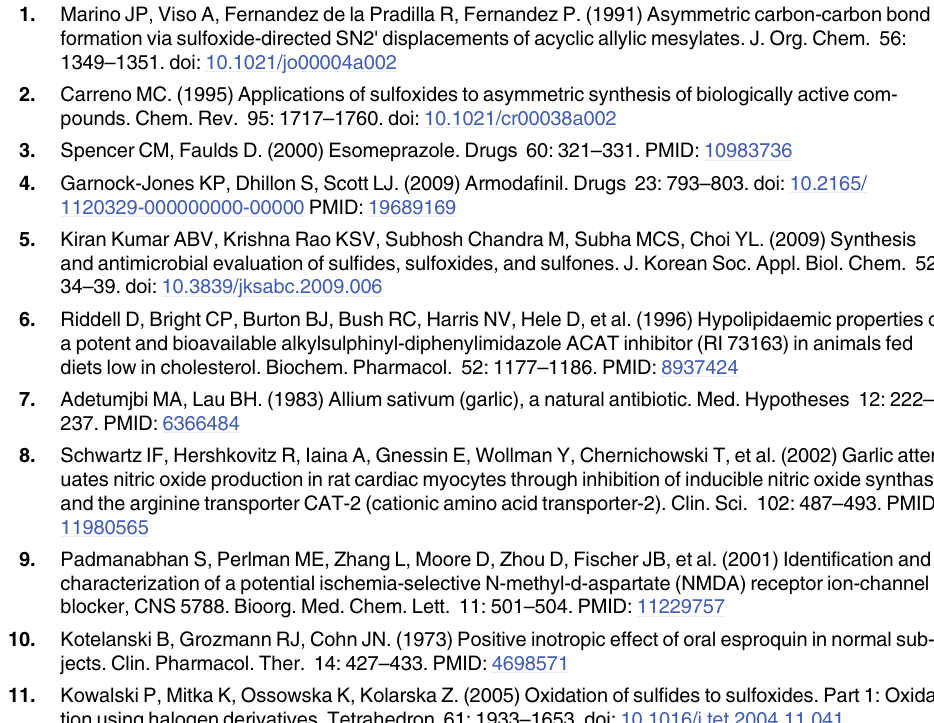
S2 Table. Percentage conversion to sulfoxides and sulfones after 1 and 30 minutes of reac- tion in the presence of D or L-DNAzyme. Reactions were carried out in the presence of DNA O (4 mM). Controls were performed using hemin (12 μ M) (12 μ M), hemin (12 μ M), and H 2 2 O (4 mM) without DNA (Control Hemin), and H O (4 mM) only (Control H O ). with H 2 2 2 2 2 2 Concentration of substrates, in reactions and controls, was 2.5 mM for thioanisole (MPS), 0.1 mM for diphenyl sulfide (DPS), 0.25 mM dibenzylsulfide (DBS), and 0.15 mM for dibenzothio- phene